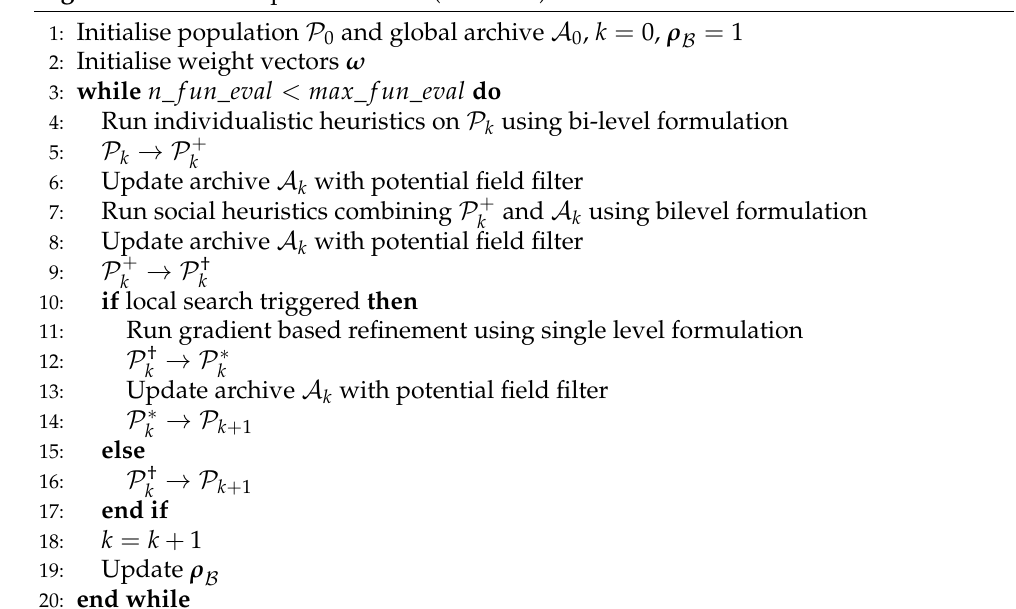
Algorithm 1 MACS optimal control